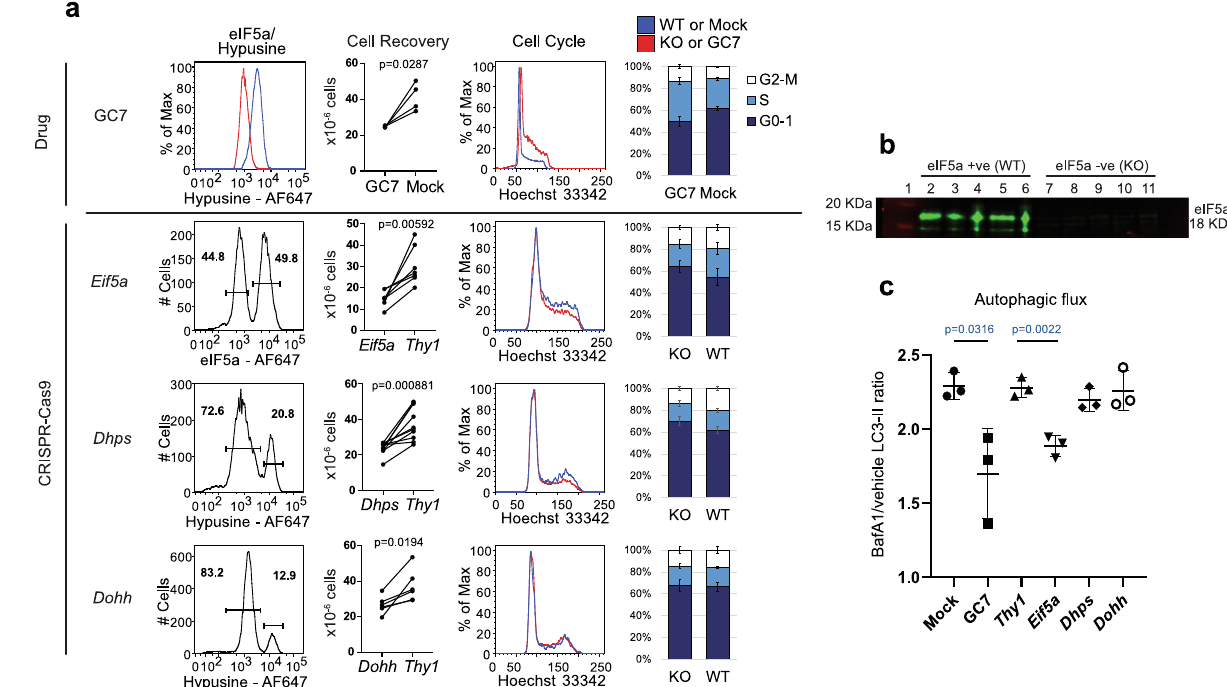
Fig. 2 | eIF5a regulates cell cycle and autophagy. a FACS overlay histograms showing expression of eIF5a or hypusine assessed at d3 (GC7 and Eif5a ) and d4 ( Dhps and Dohh ).KOof cellsurfacemarkerThy1 wasincluded asaCRISPR control. Cell Recovery column shows the number of cells recovered at the time of harvest for each treatment paired to their control treatment (mock-treatment for GC7 and Thy1 KOforCRISPRcells, n =4independentexperimentsforGC7,7for Eif5a ,10for Dhps , 6 for Dohh ). Cell cycle pro fi les were obtained from Hoechst 33342 staining. Mean percentage of cell cycle phases was plotted, pairing positive and negative cells from individual cultures ( n =4 independentexperiments for GC7,12 for Eif5a , 7for Dhps ,8for Dohh ).ErrorbarsrepresentSDbetweenexperiments.Pvalueswere calculatedusingapairedtwo-sided t test.Lines:blue,WTorMock;red,KOorGC7. Bars:darkblue,G0-1;lightblue,S;white,G2-M. b Westernblotof Eif5a -CRISPRcells